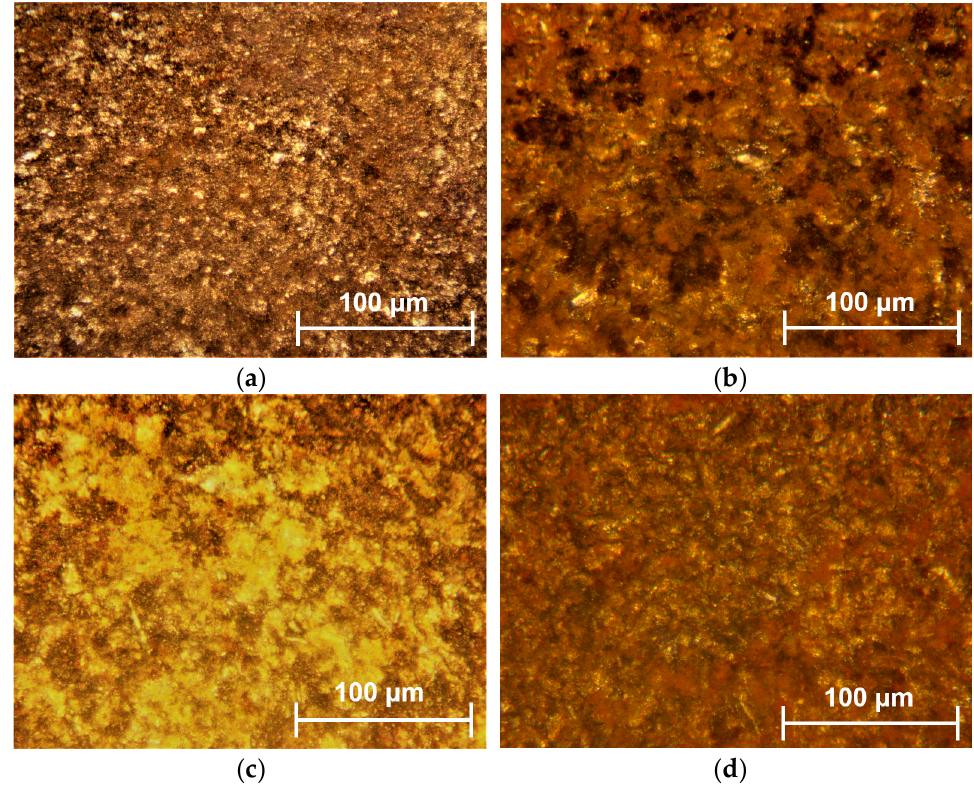
Figure 9. Optical microscopy after corrosion of S235JR immersed during 336 h in 3.5 NaCl solution for: ( a ) S235JR—non-sandblasted, ( b )—S235JR—sandblasted with quartz, ( c )—S235JR—sandblasted with garnet, ( d )—S235JR—sandblasted with alumina.